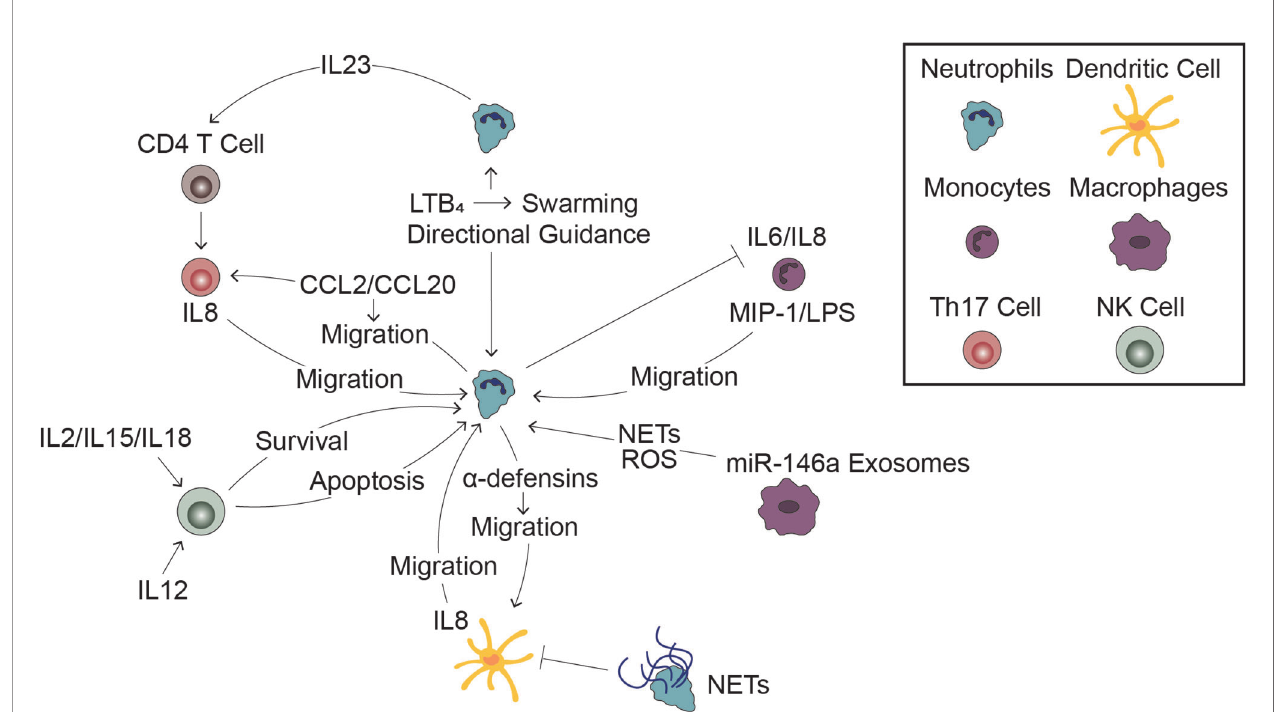
FIGURE 3 | Interactions with Immune Cells In fl uences the Neutrophil Response. Cell-cell signaling between neutrophils and other immune cells plays a signi fi cant role in the innate immune response to infection. Leading neutrophils in fl uence swarming and the directional migration of trailing neutrophils (top middle). Monocytes induce neutrophil migration and in turn, neutrophils inhibit pro-in fl ammatory signaling by monocytes (top right). Release of miR-146a rich exosomes induces neutrophil extracellular trap formation and reactive oxygen species generation (bottom right). Dendritic cells stimulate neutrophil migration while neutrophils have a dual effect on dendritic cells, stimulating migration through release of a -defensins while reducing DC production of in fl ammatory signals through signaling through NETs (bottom middle). NK cells can both promote neutrophil survival following stimulation by pro-in fl ammatory cytokines and promote neutrophil apoptosis following stimulation with anti-in fl ammatory cytokines (bottom left). Neutrophils stimulate Th17 cell migration and induce CD4 T cells to become Th17 cells, which in turn stimulate neutrophil migration (top